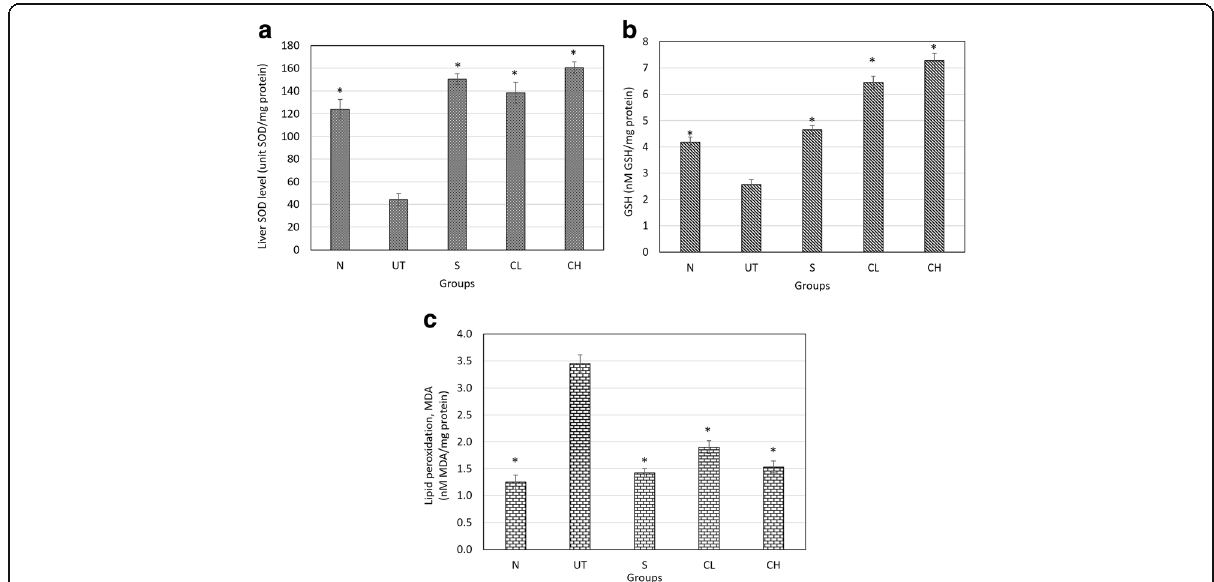
Fig. 2 Effect of coconut water vinegar on liver a SOD b GSH and c MDA levels in the liver of acetaminophen-challenged mice. All values are expressed as means mean ± SD of 6 mice in each group. * P < 0.01 as compared with the untreated control group. N: normal healthy control; UT: untreated acetaminophen-induced control; S: acetaminophen-induced treated with 50 mg/kg silybin; CL: acetaminophen-induced treated with 0.08 ml/kg coconut water vinegar; CH: acetaminophen-induced treated with 2 ml/kg coconut water